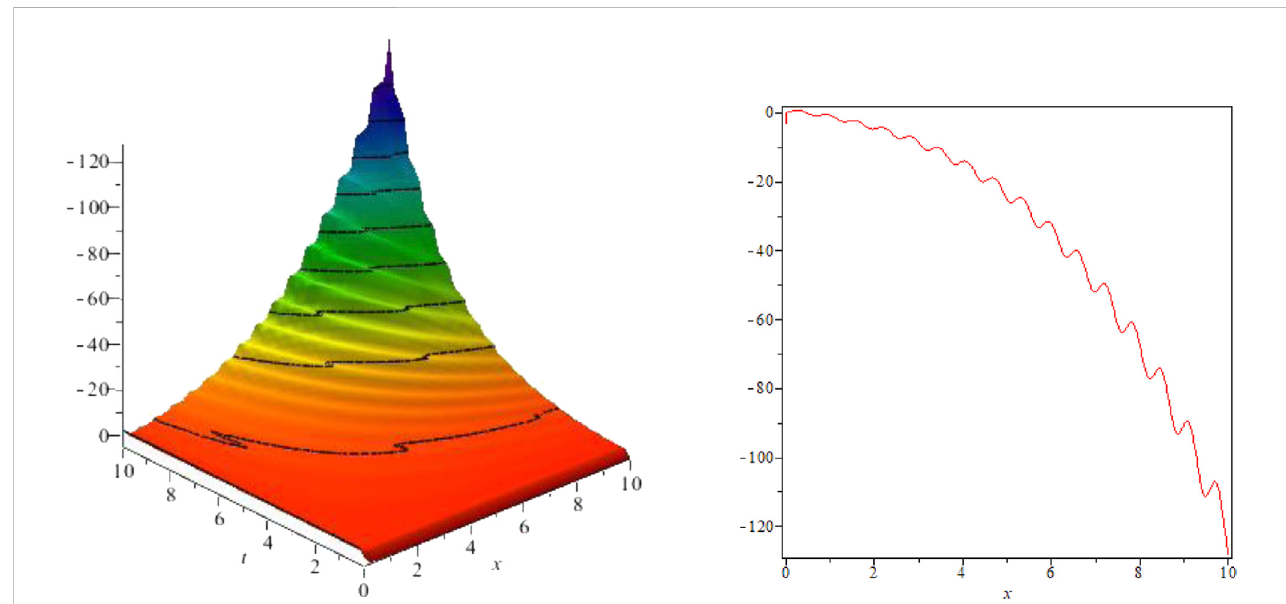
FIGURE 5 Kink-shaped solution for Eq. 35 for Y 24 at ω (cid:2) 1 , k (cid:2) 1 , a 0 (cid:2) 1 , a 1 (cid:2) − 1